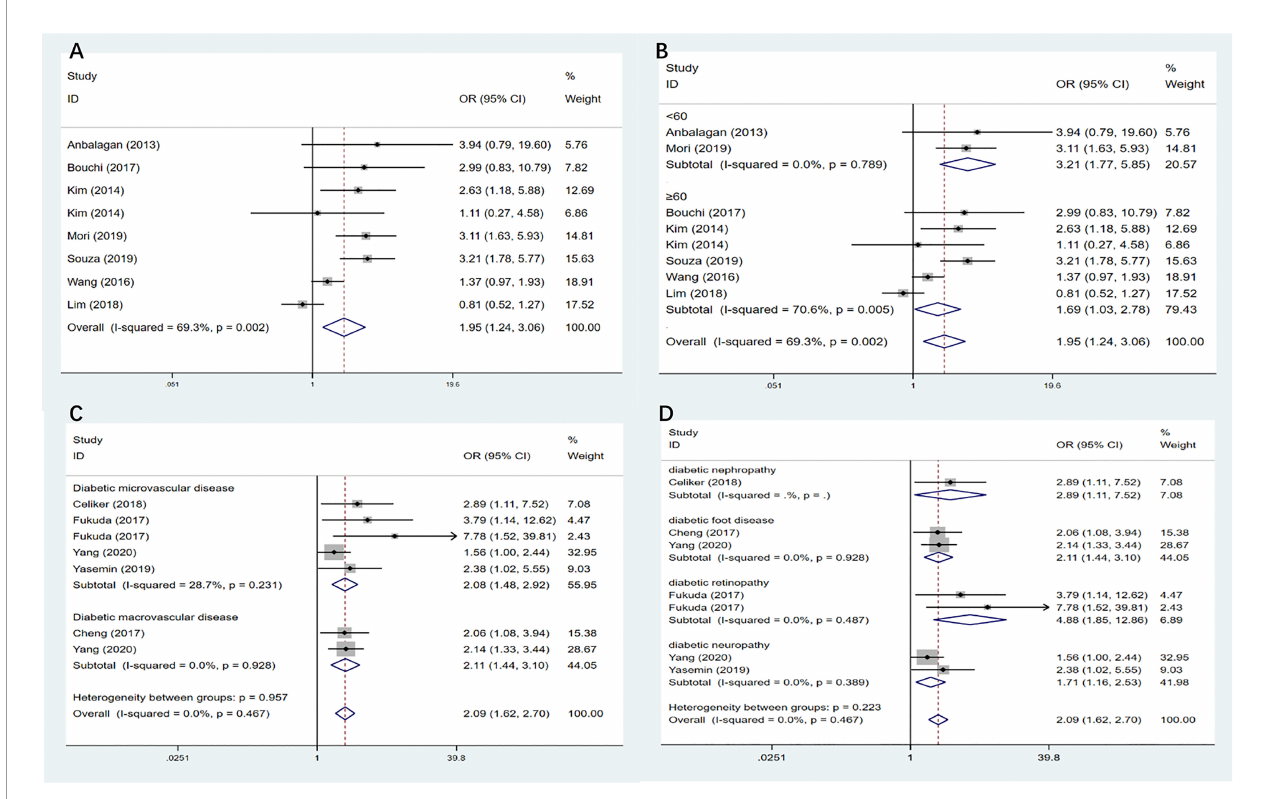
FIGURE 2 | (A) Meta-analysis of the association between diabetes and the risk of sarcopenia. (B) Subgroup analysis of the association between diabetes and the risk of sarcopenia according to age. (C) Subgroup analysis of the association between diabetes complications and the risk of sarcopenia according to diabetic vascular disease. (D) Subgroup analysis of the association between diabetes complications and the risk of sarcopenia according to different diabetic complications. OR, odds ratio; CI, con fi dence interval. Where I 2 is the variation in effect estimates attributable to heterogeneity, overall is the pooled random/ fi xed effect estimate of all studies. subtotal is the pooled random effects estimate of sub-group analysis studies. Weights are from random-effects analysis. %Weight is the weight assigned to each study, based on the inverse of the within- and between-study variance. The size of the grey boxes around the point estimates re fl ects the weight assigned to each study.